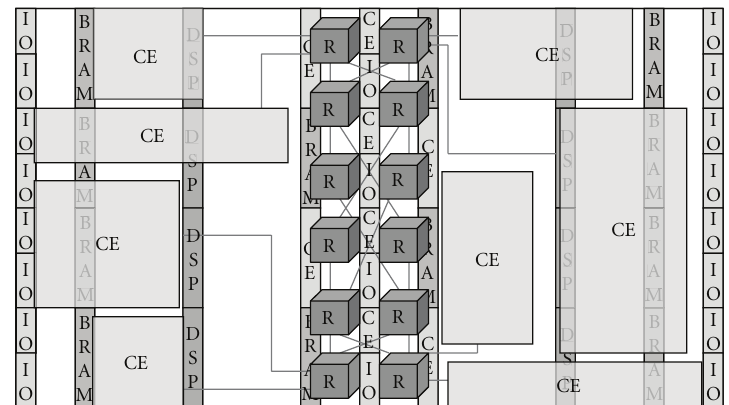
Figure 9: Implementation of DRAFT as a central column interconnecting CEs which are located into both halves of the FPGA.